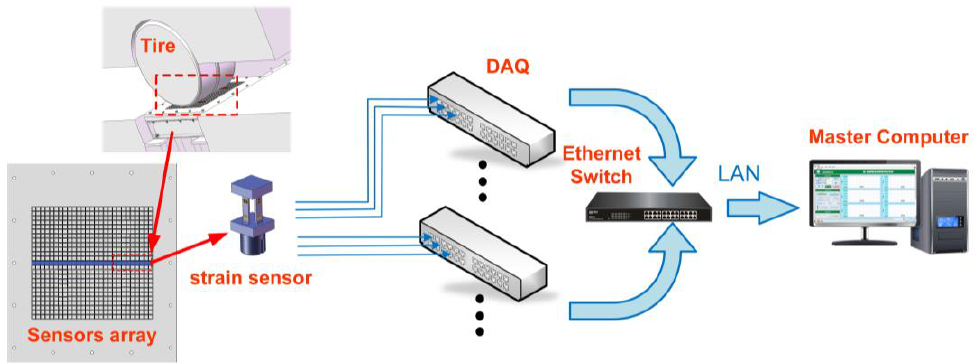
Figure 6. Master system data acquisition